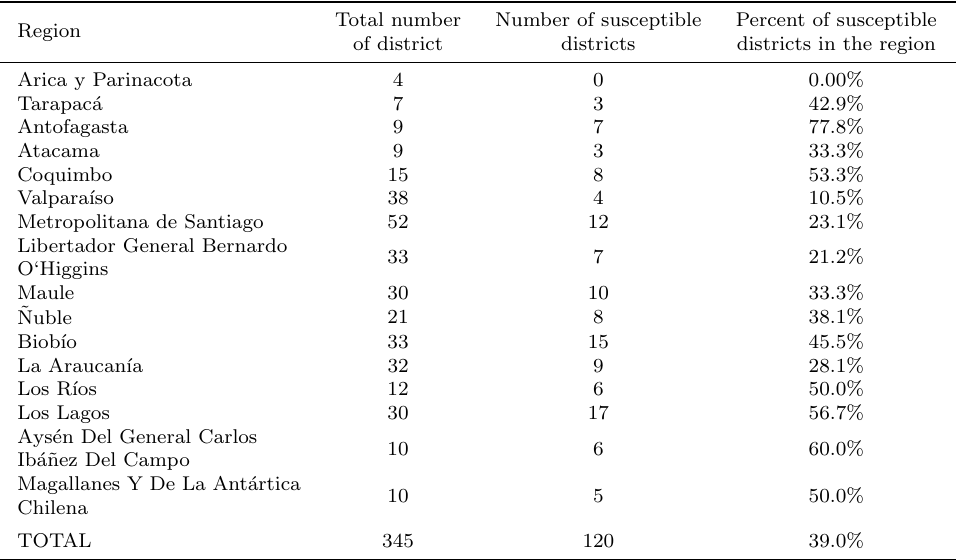
Table 1: Percent of susceptible districts to be lag zones by region in Chile Total number Number of susceptible Percent of susceptible Region of district districts districts in the region Arica y Parinacota 4 0 0.00%